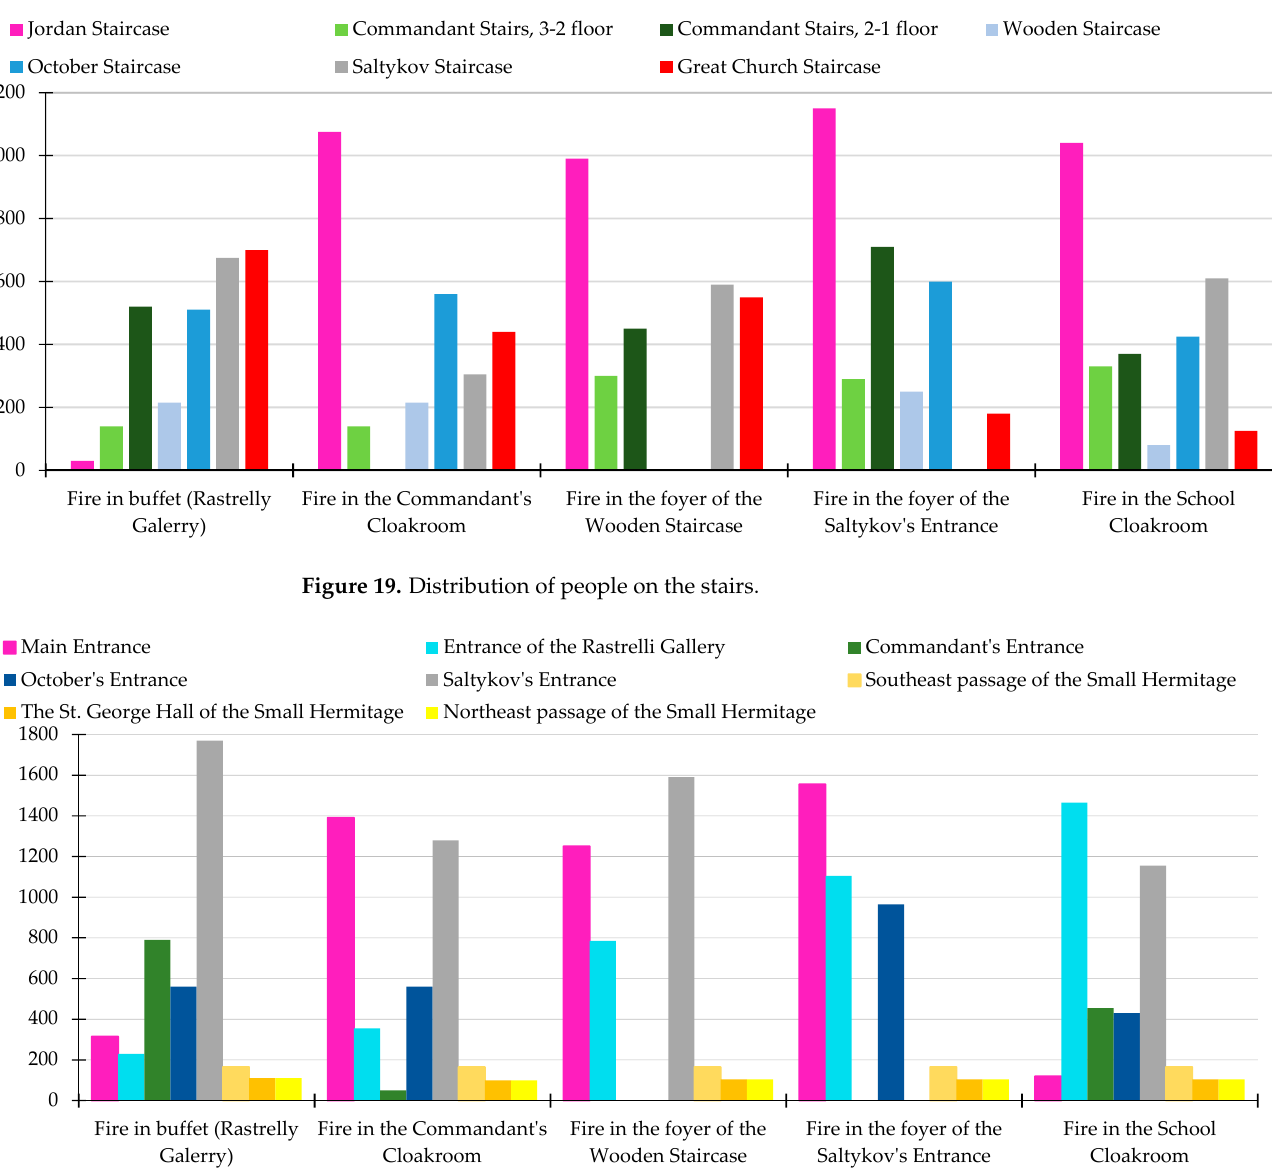
( c ) Figure 18. Scheme of evacuation of people from the Winter Palace for the scenario “Fire in the School Cloakroom”: ( a ) for the 3rd floor; ( b ) for the 2nd floor; and ( c ) for the 1st floor.